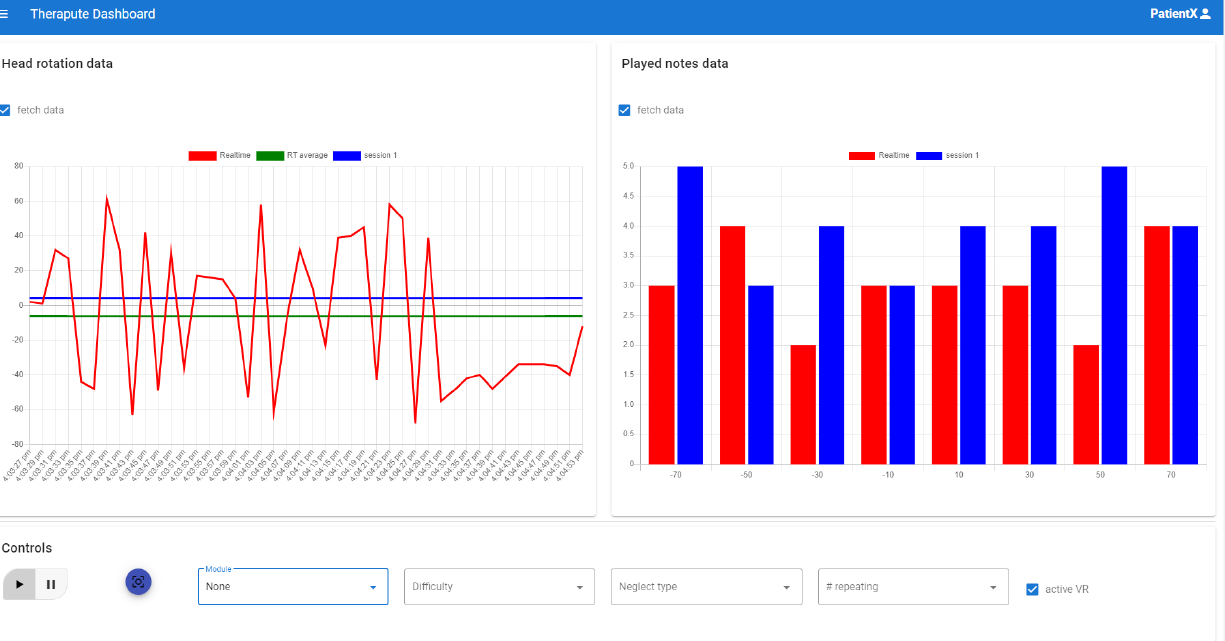
Figure 9. Therapist dashboard to control and oversee the